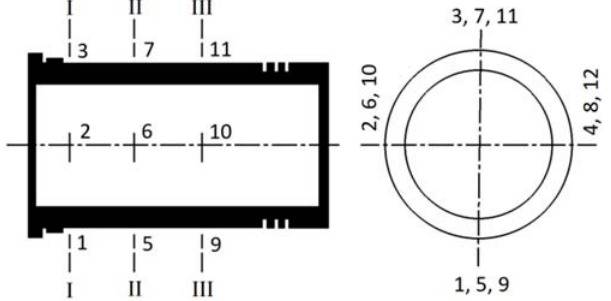
Fig. 8. Position of cylinder liner temperature